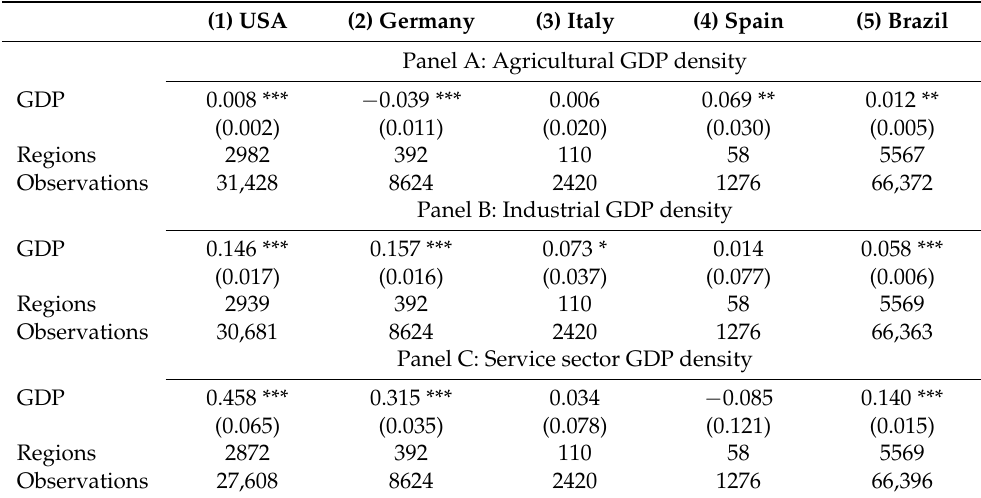
Table 4. Income elasticity of nighttime lights across economic